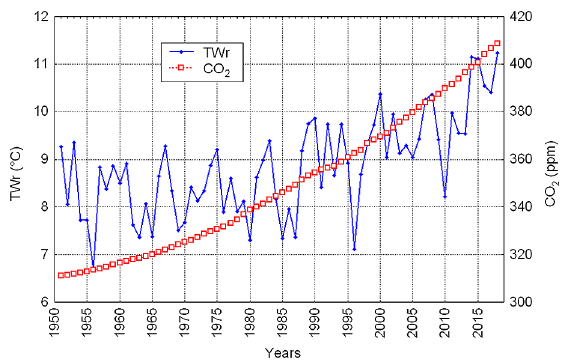
Fig. 5. The courses of the annual air temperature in Wrocław (TWr) and the average annual values of CO concentration in the atmosphere.